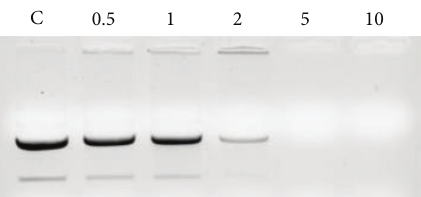
Figure 1: Agarose gel electrophoresis result of MPD polyplexes. C: pDNA only. Numbers mean weight ratios of the